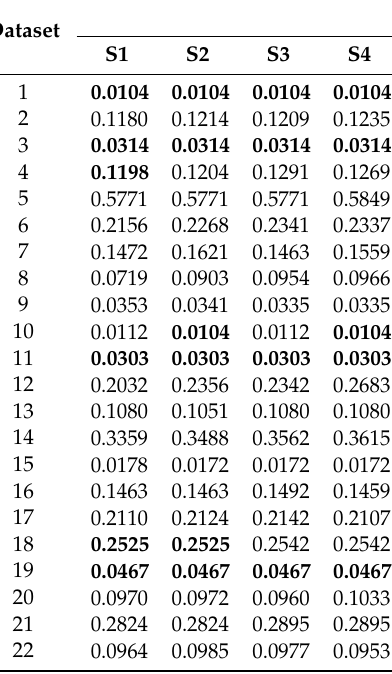
Table 4. Experimental result of the best fitness value of the proposed